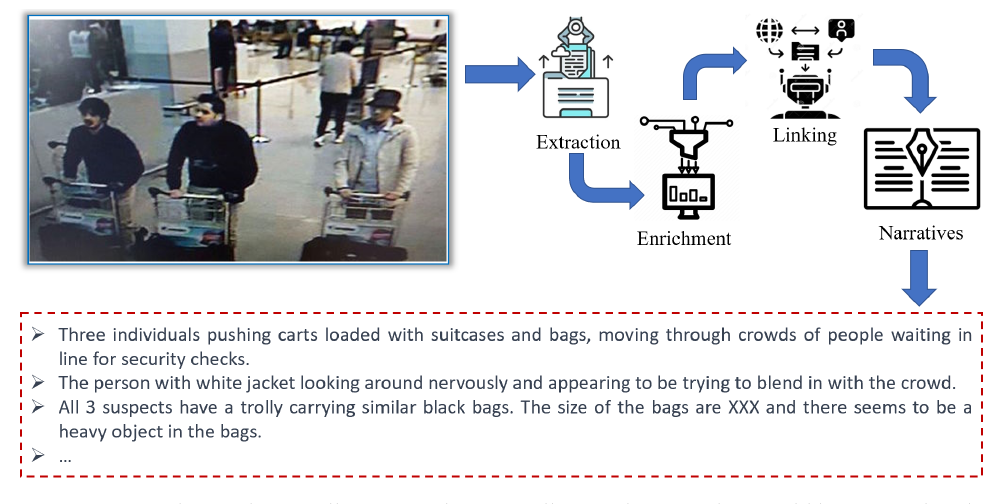
Figure 1. An end-to-end storytelling example. Storytelling with image data could be a critical tool in preventing events like the 2016 Brussels bombings. By analyzing and connecting images from various sources, including security cameras and social media, authorities can identify potential threats and act preemptively to ensure public